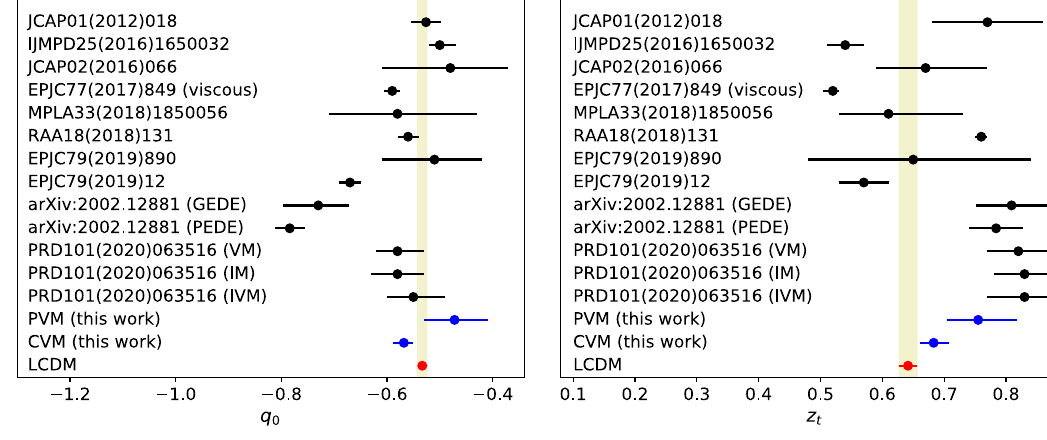
Fig. 4 Comparison of the q 0 and z t . The vertical band represents the uncertainty at 1 σ of the LCDM